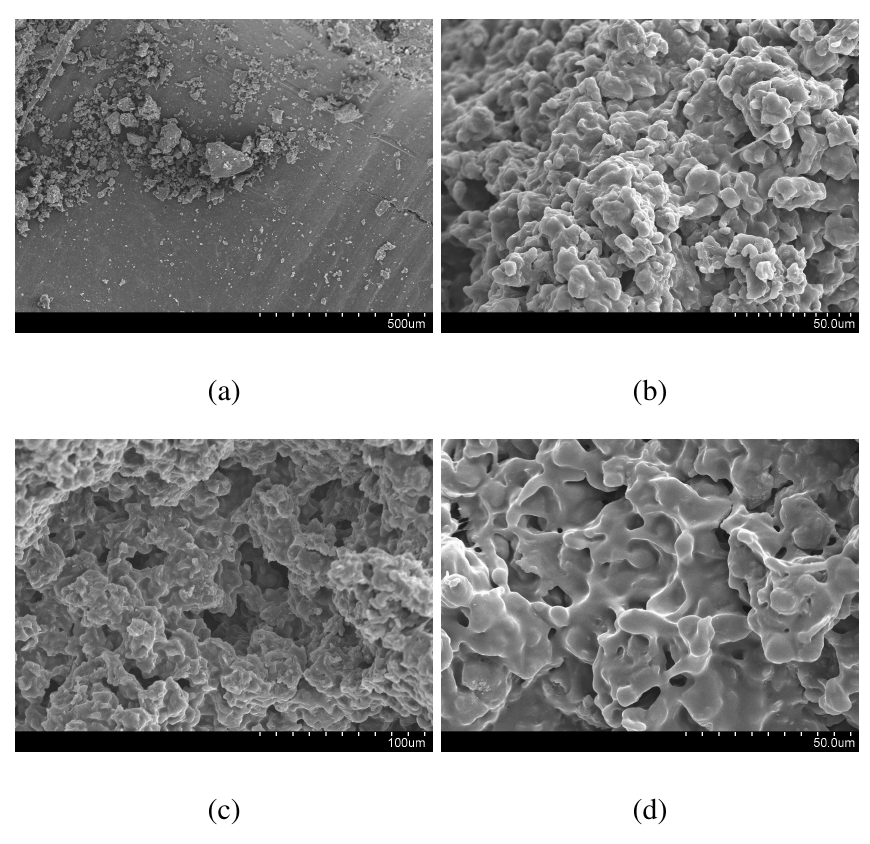
Figure 6. SEM image of (a) PC, (b) PC80/PCL20, (c) PC75/PCL25, (d)